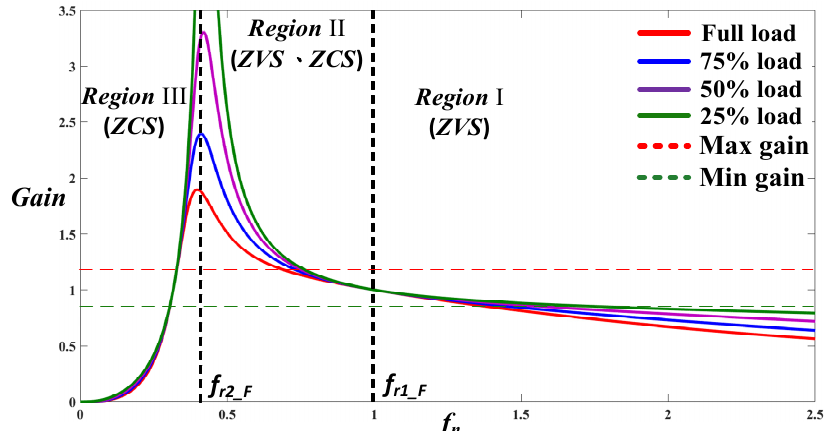
Figure 3. Voltage gains by the resonant converter under various loads.